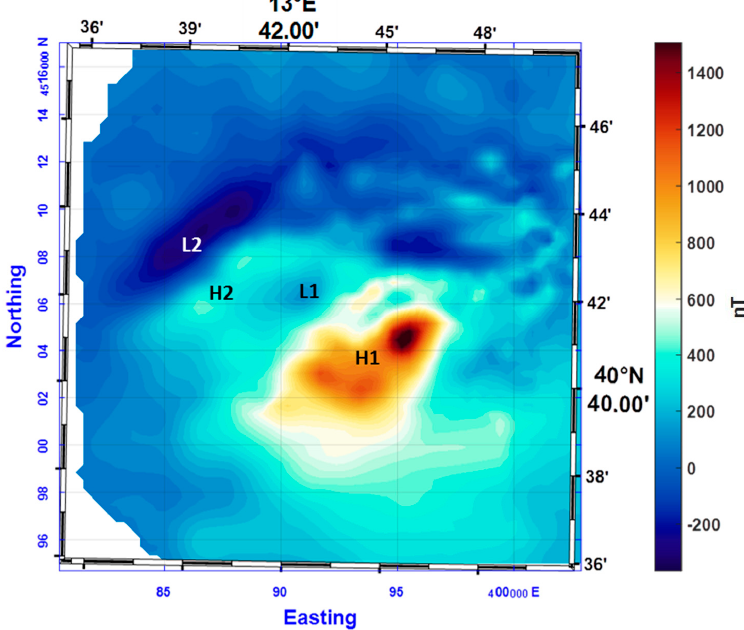
Figure 4. Total field shipborne magnetic anomalies in the area west of Ischia Island. Letters identify single magnetic anomalies described in the text.